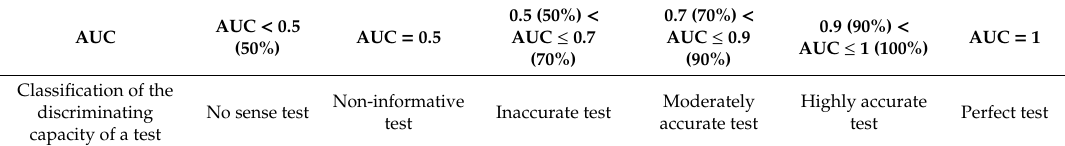
Table 6. AUC values [39].